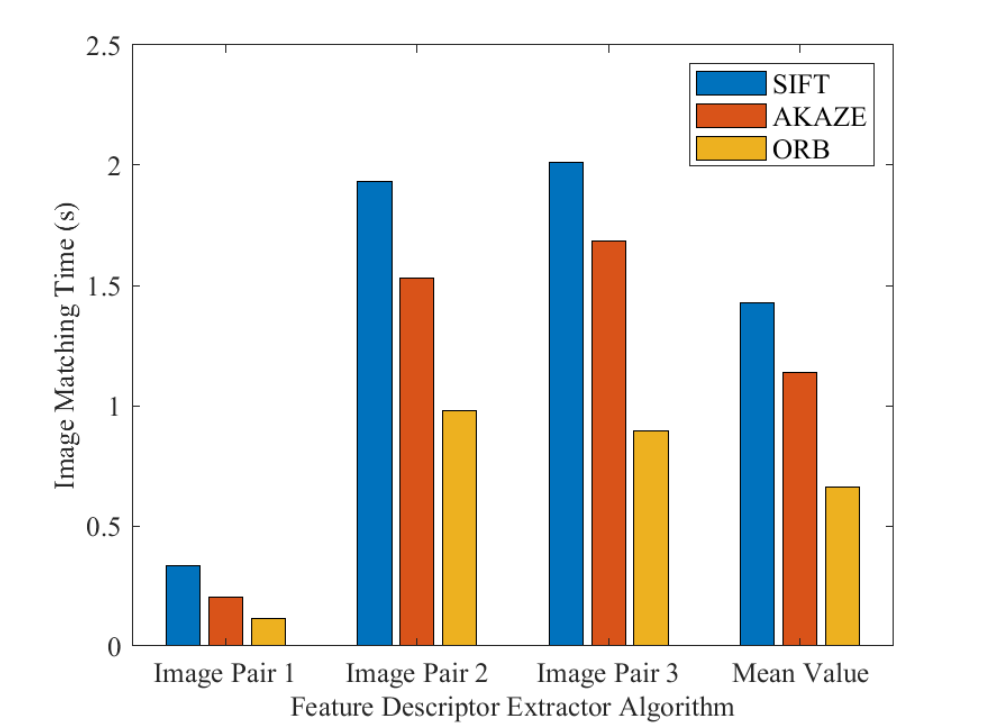
Figure 11. A comparison of the computational costs of SIFT, AKAZE, and